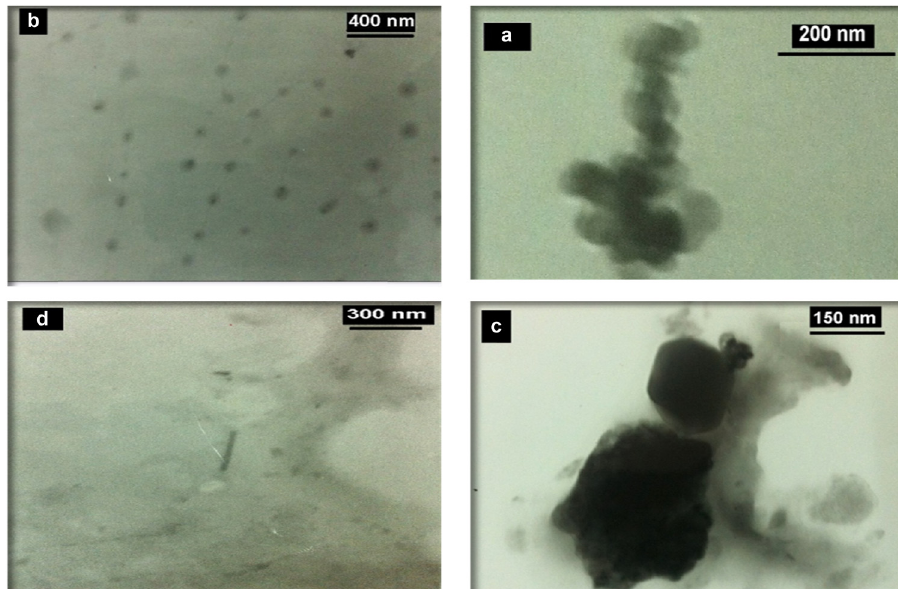
Figure 13: TEM images of reinforced PVA coating. ( a ) Formation of clusters from the assembly of 35 – 70nm diameter spherical reinforced PVA macromolecules above each other; ( b ) nano - size spherical macromolecules bounded to each other, in a linear form, through a very fi ne angstrom - size thread; and ( c and d ) free and unbounded spheres and spheroids of reinforced PVA macromolecules fl owing around in solution.